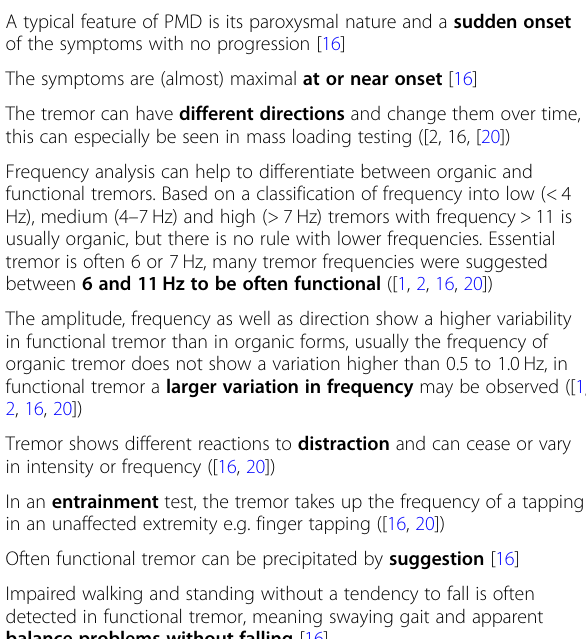
Table 3 Clinical features of organic tremor evaluated and described in studies Clinical